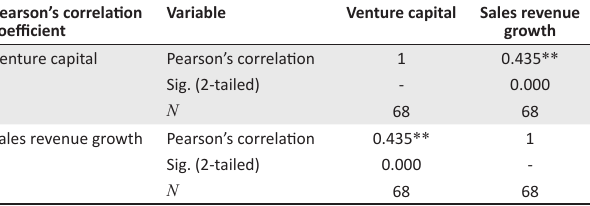
Sales revenue growth Pearson’s correlation